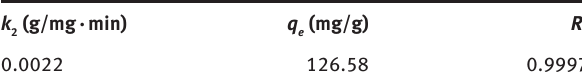
Table 1: Parameters of the Cd 2 + removal process calculated using McKay and Ho’s pseudo-second-order law model.